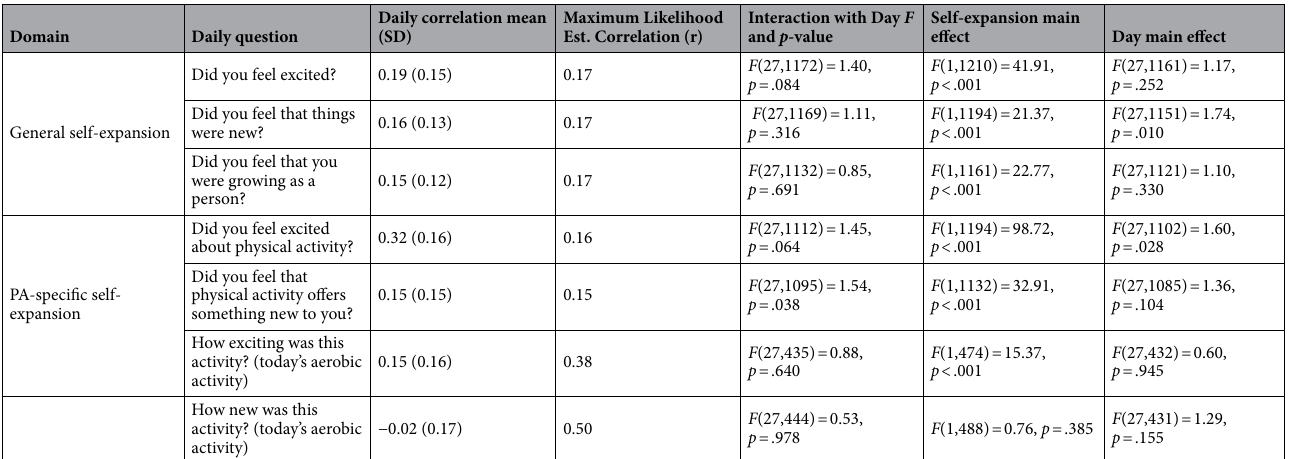
Table 1. Daily correlation between self-expansion measures and daily steps mean (standard deviation), maximum likelihood estimated correlation found using a mixed model, and test statistic and p -value for examining the association between Fitbit average daily steps and self-expansion using a mixed effects model. N = 49 for all